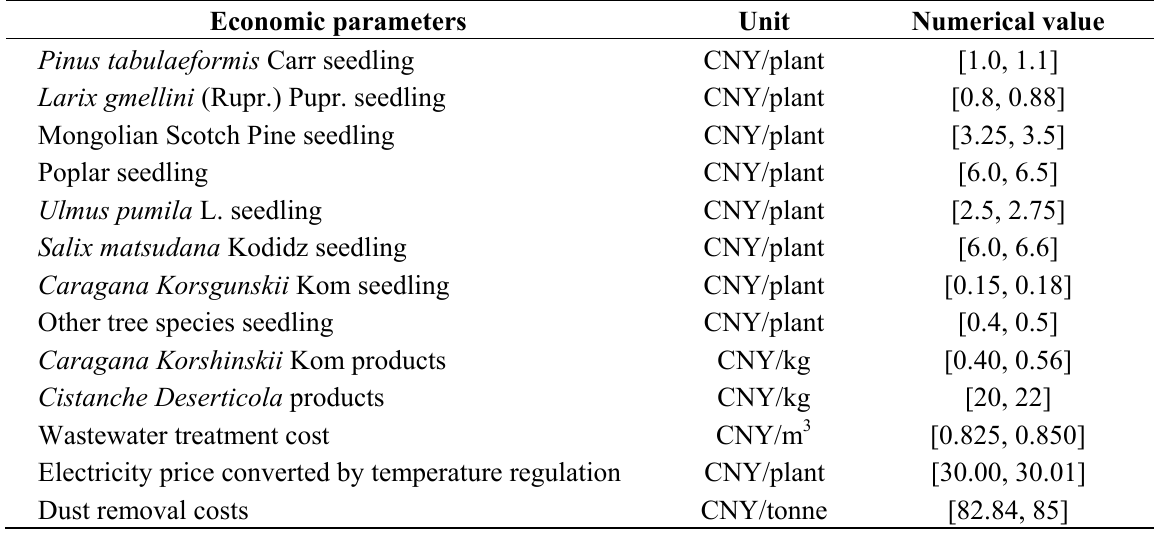
Table 7. Economic parameters of the CDM forestry project. Economic